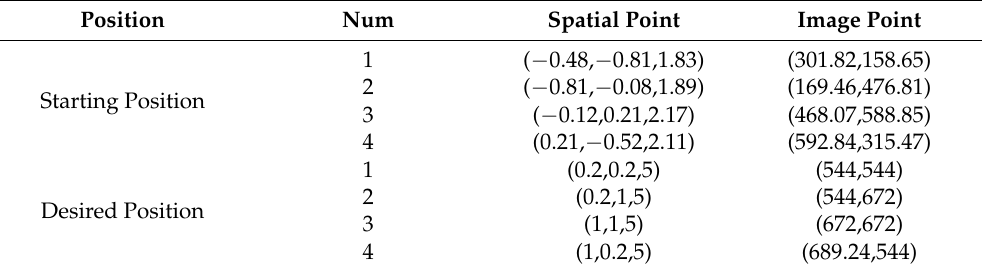
Table 3. Starting and Desired Positions of Feature Points In The